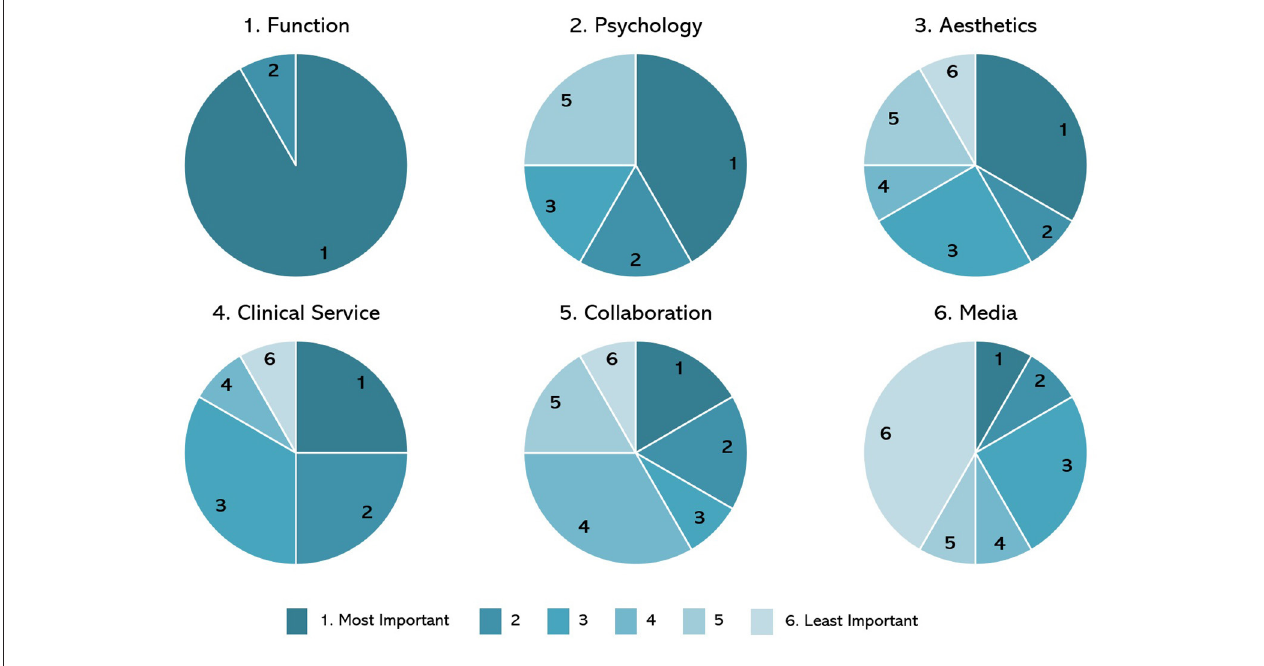
FIGURE 2 | Pre-workshop survey results.